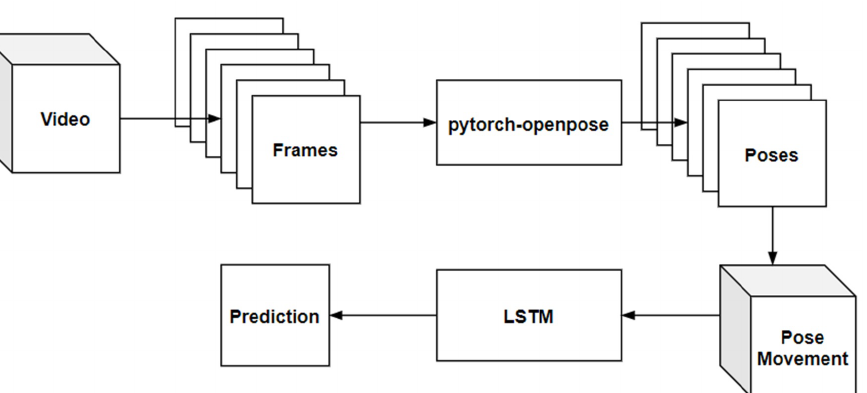
Figure 3. The proposed deepfake detection method: The proposed method will extract the frames (30 fps) from the input video. Later OpenPose software is used to extract key-point of each pose of the person. The proposed LSTM architecture trains the pose movement. The final inference system will classify that given a video of the US president is fake or